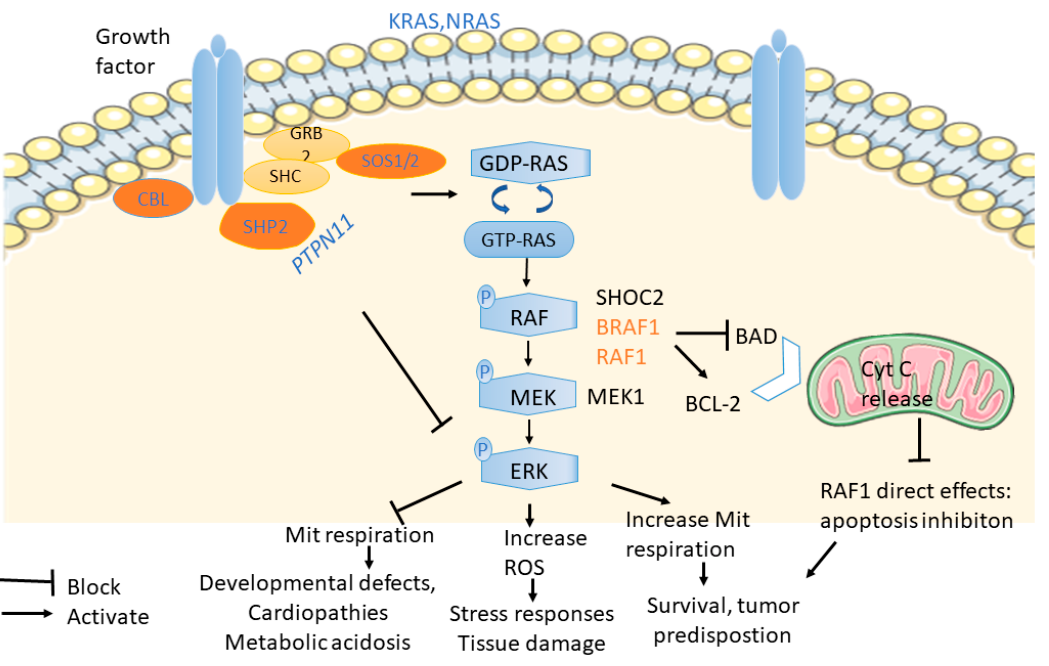
Figure 5. An overview of the effects of NS/NSML mutations on mitochondria metabolism via RAS signalling. The sequence of events coordinated by the major RAS/MAPK signalling and other pathways such as P13K/AKT results from the activation or inactivation of heterozygous/homozygous mutations in genes: PTPN11, SOS1/2, RAS, RAF1, BRAF1, NRAS, KRAS, CBL that cause NS and related syndrome. Outcomes observed include decreasing or increasing mitochondria metabolism, increasing ROS, and inhibiting apoptosis.